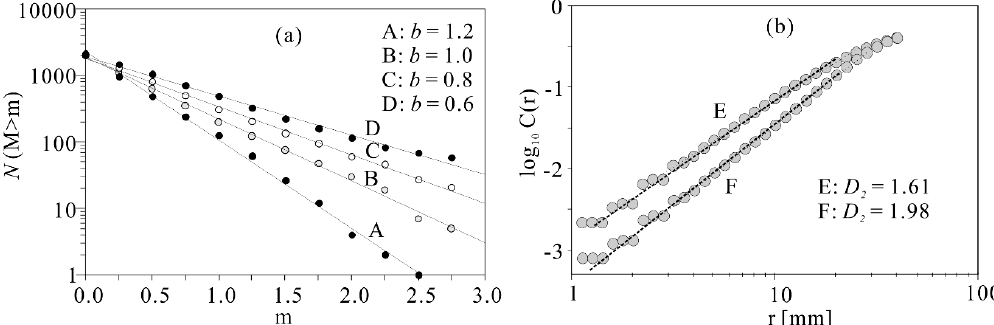
Figure 3. Examples of ( a ) frequency-magnitude distribution and ( b ) and correlation function for selected data points A–F. selected data points